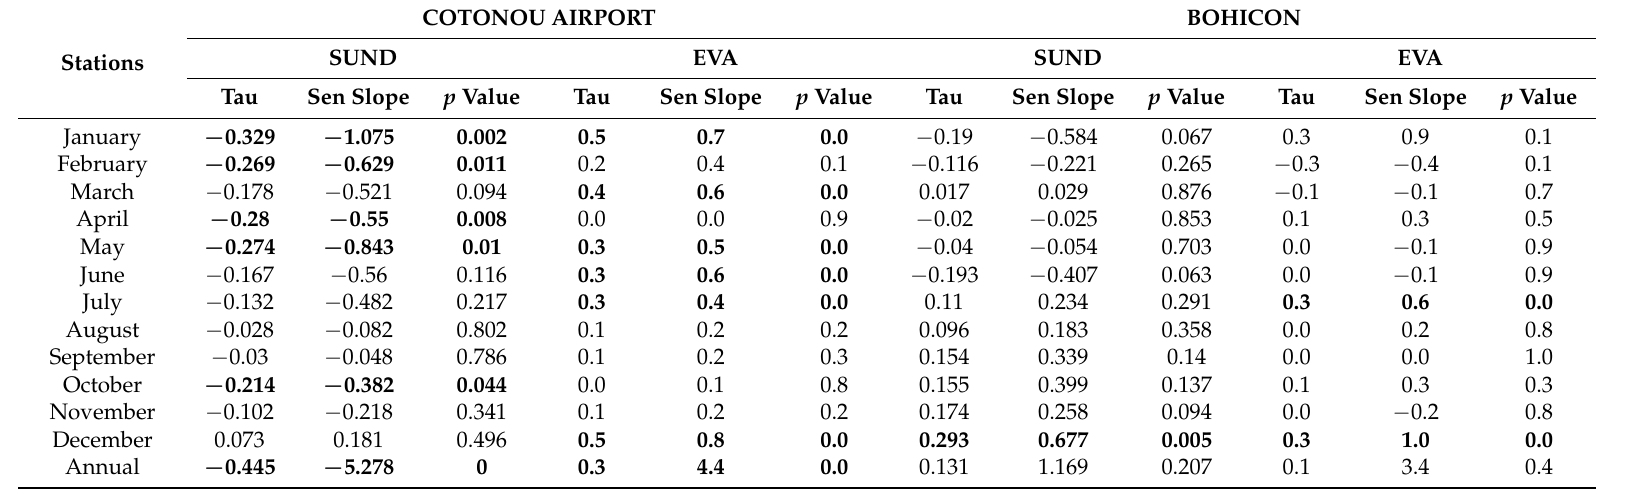
Table 12. Monthly and annual significant trend for sunshine and pan